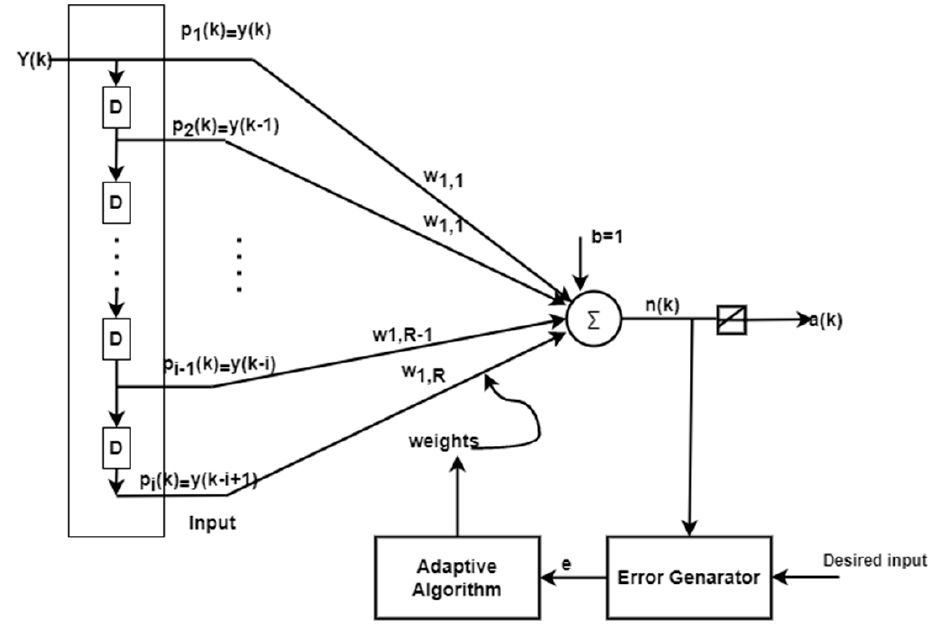
Figure 5. ADALINE as an adaptive filter.